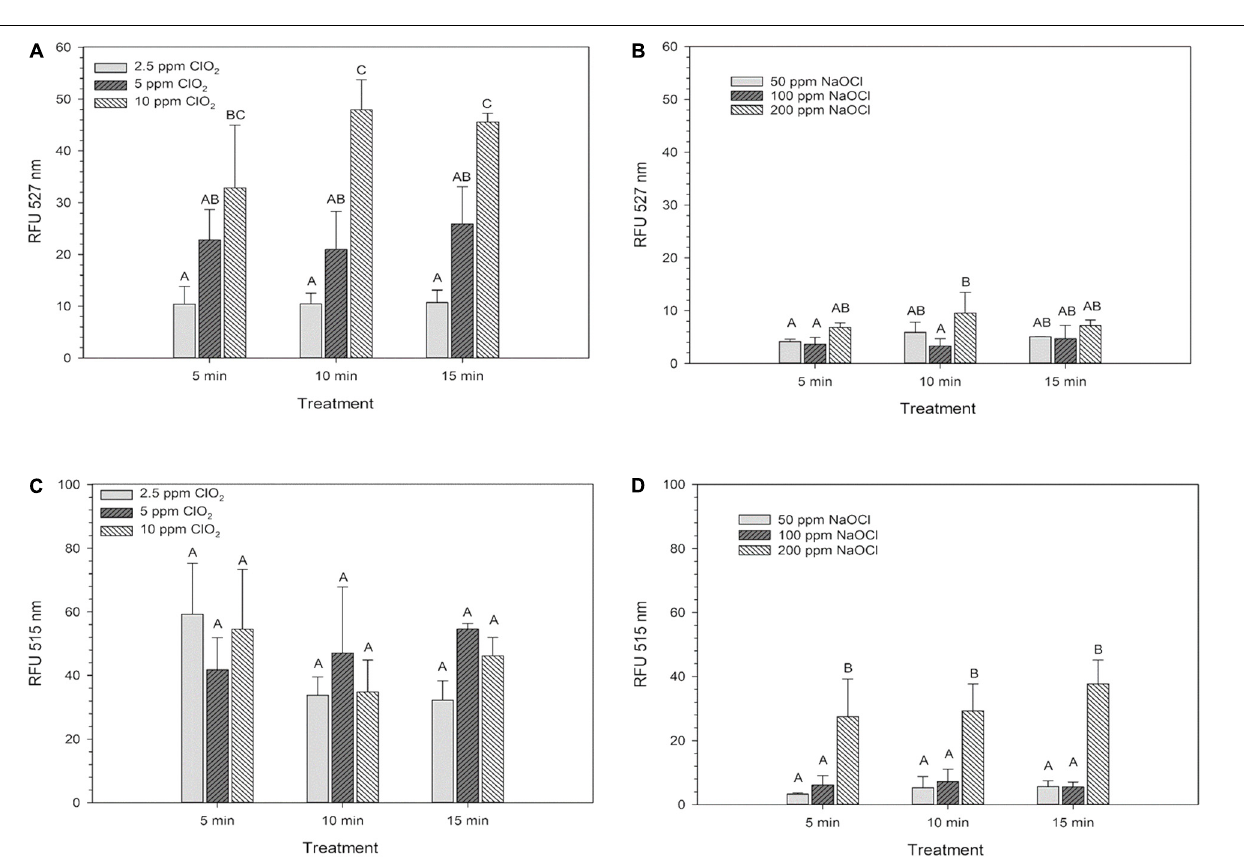
TABLE 1 | Log relative expression of select genes after treatment of Escherichia coli O157:H7 with NaClO or ClO 2 . Sanitizer